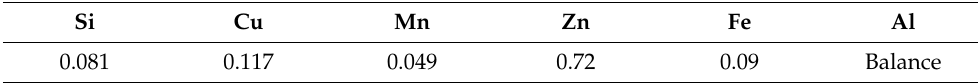
Table 1. Chemical composition of the sheet, as